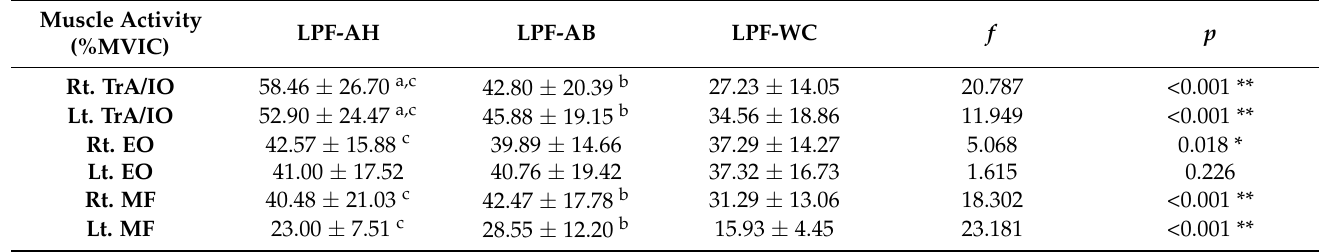
Table 1. Electromyography activities of each muscle among three conditions ( n = 20).